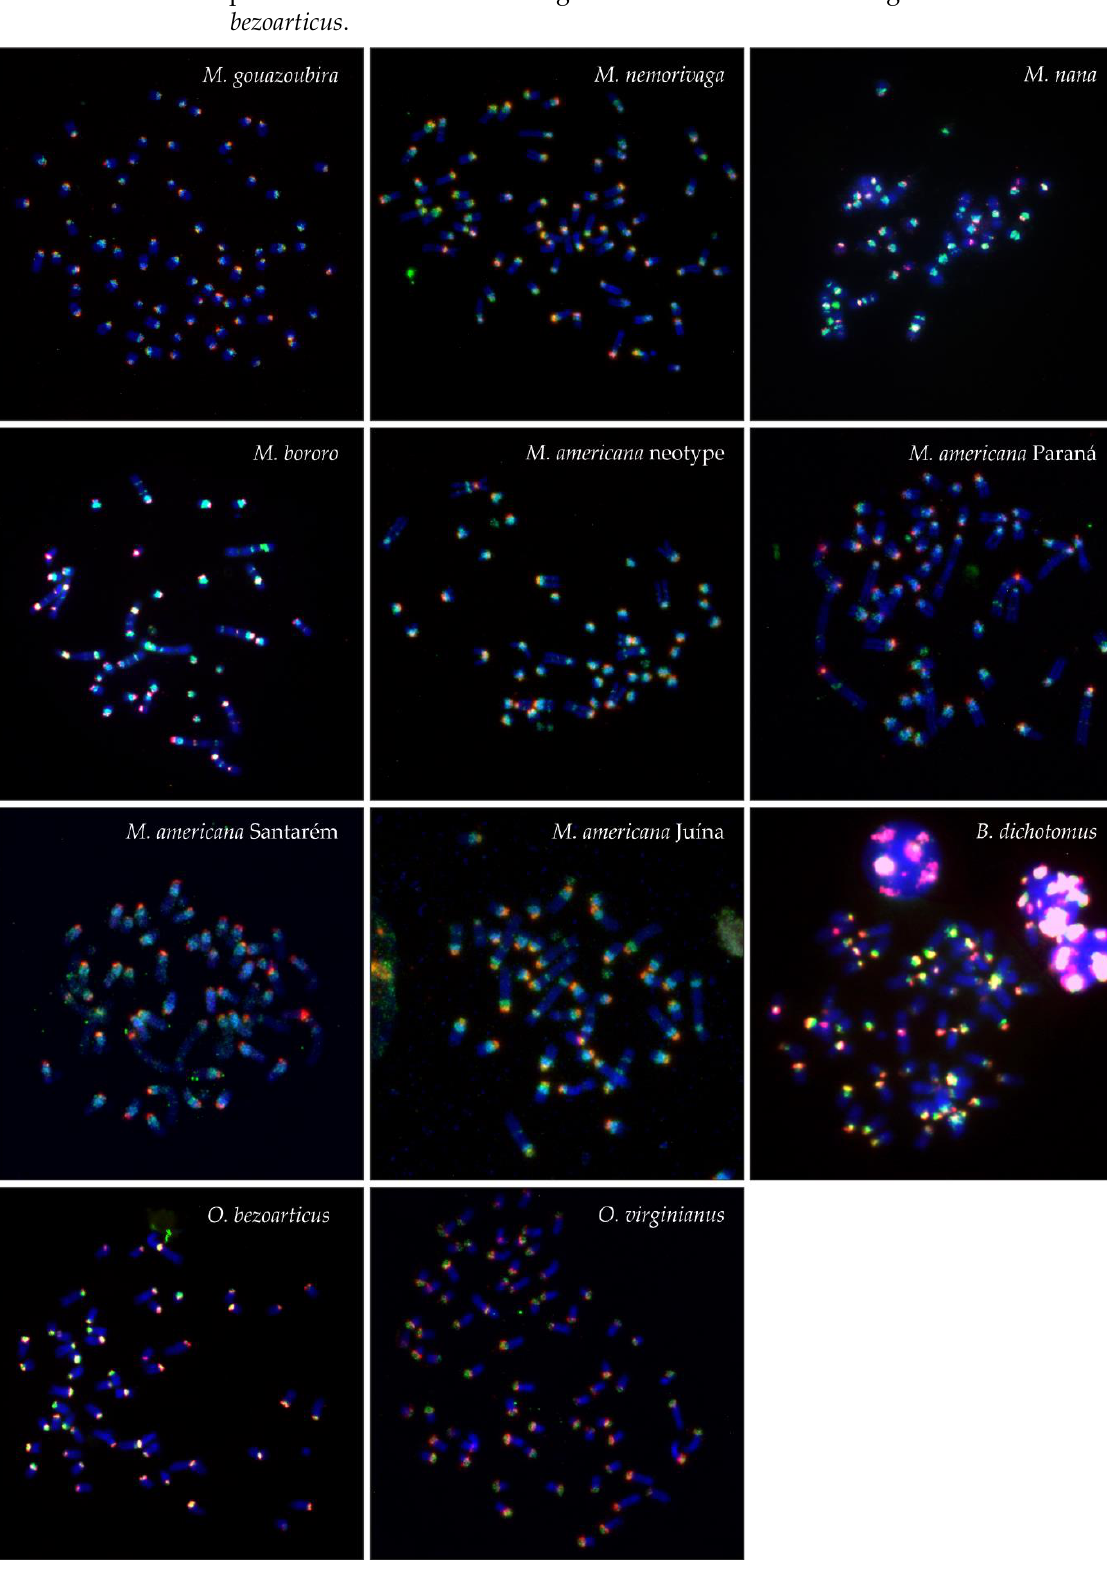
Figure 1. FISH patterns of the satI ( green ) and satII ( red ) DNA probe in the analyzed species.